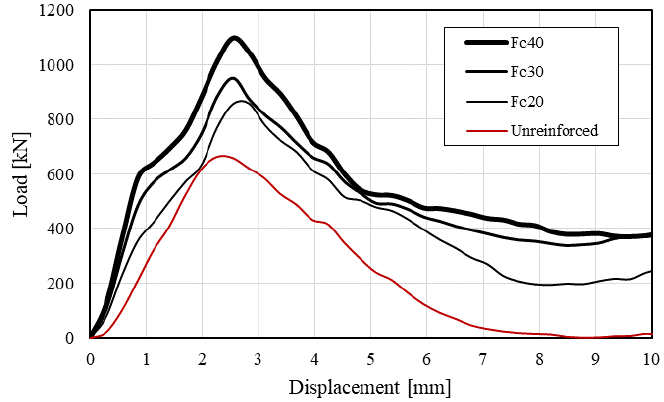
Figure 26. Load–displacement curves for different plaster strengths.